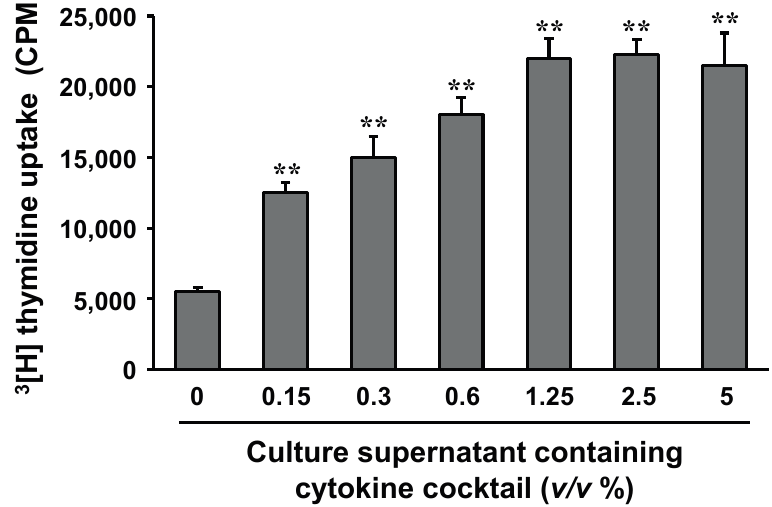
Figure 5. Effects of cytokines produced by Peyer’s patch cells stimulated with the Aloe polysaccharides on the proliferation of bone marrow cells. Peyer’s patch cells isolated from control mice were stimulated with 100 μ g/mL of polysaccharides for 3 days. The indicated amounts of the cytokine-containing cell culture supernatants ( v / v %) were added to cultures of mouse bone marrow cells. ** indicates p < 0.01, compared to culture supernatant-untreated